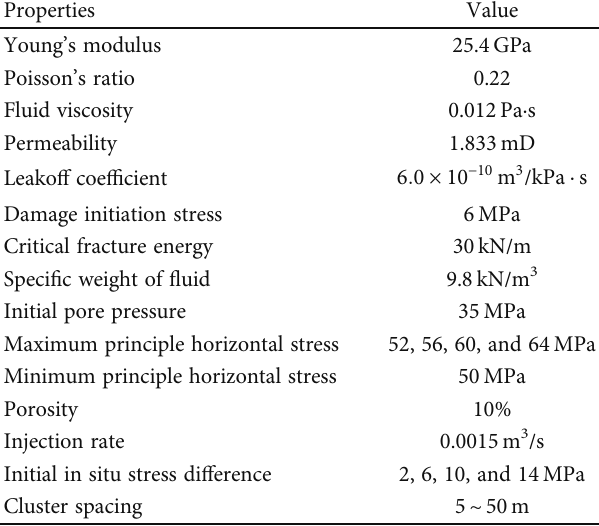
Table 2: Parameters for the hydraulic fracturing